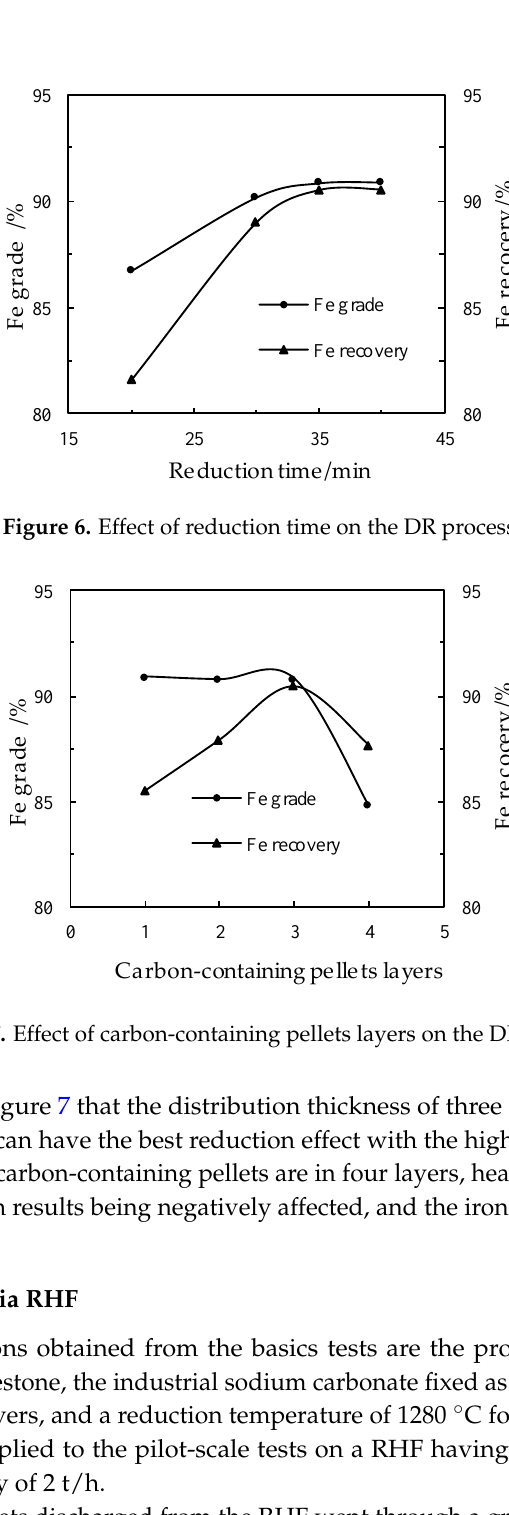
Figure 7. Effect of carbon-containing pellets layers on the DR process.